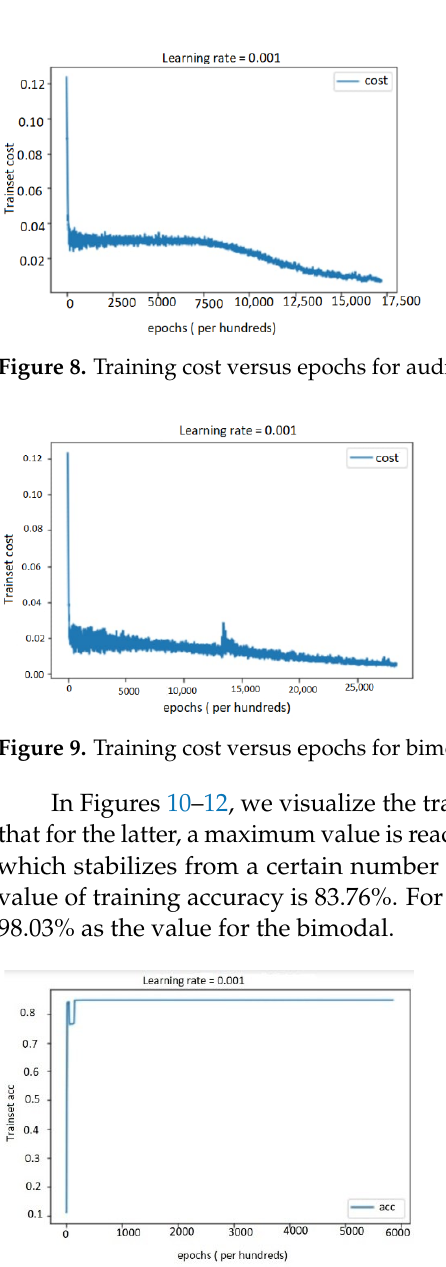
Figure 7. Training cost versus epochs for text modality.